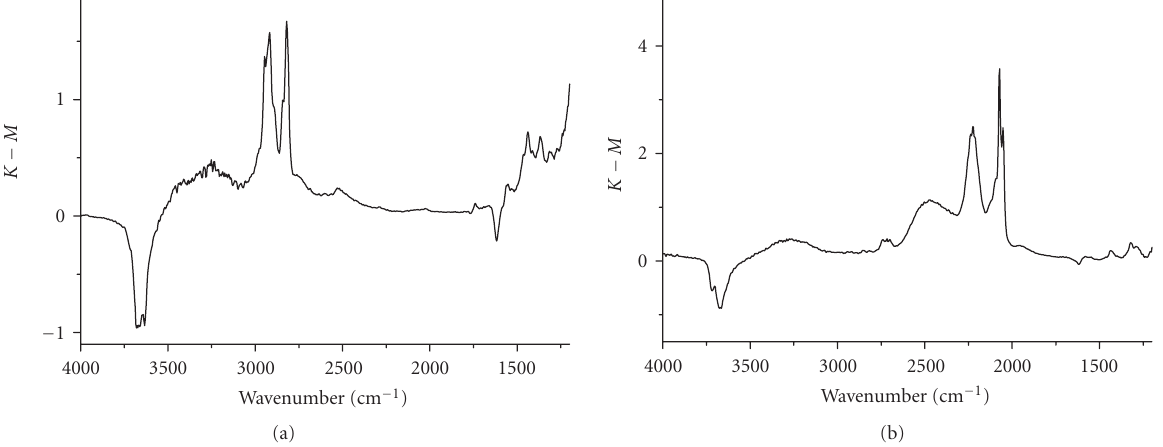
Figure 7: DRIFT spectra showing surface coverage of methanol and methanol-d4.